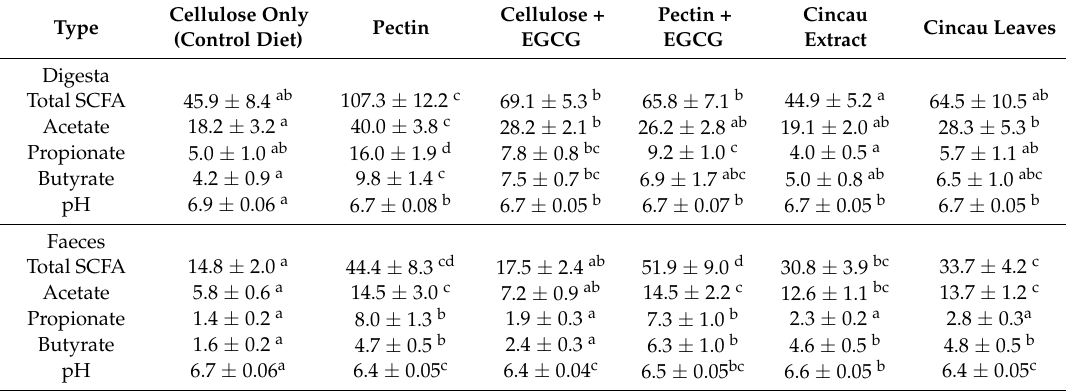
Table 1. Effects of different diets on short chain fatty acids (SCFA) concentration ( µ M/g) and pH in the digesta and faeces from rats six weeks after the second injection with the carcinogen azoxymethane (AOM) (2 × 15 mg/kg) ( n =